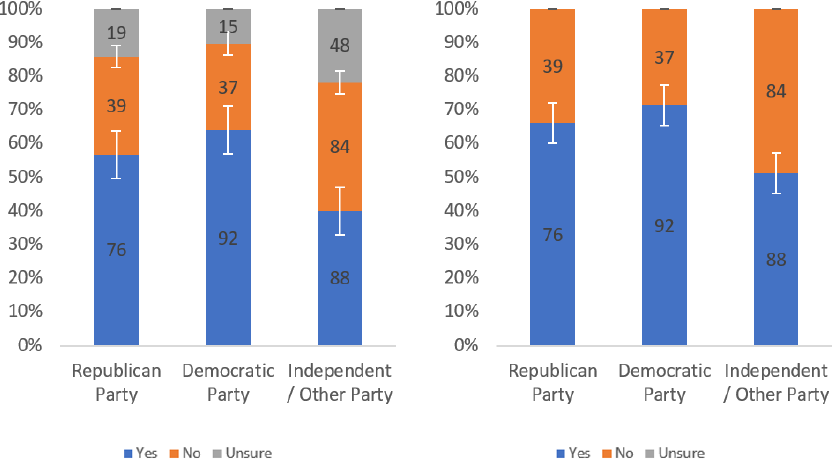
Figure 68. Responses regarding usefulness in judging trustworthiness by party affiliation including ( left ) and excluding ( right ) unsure responses.